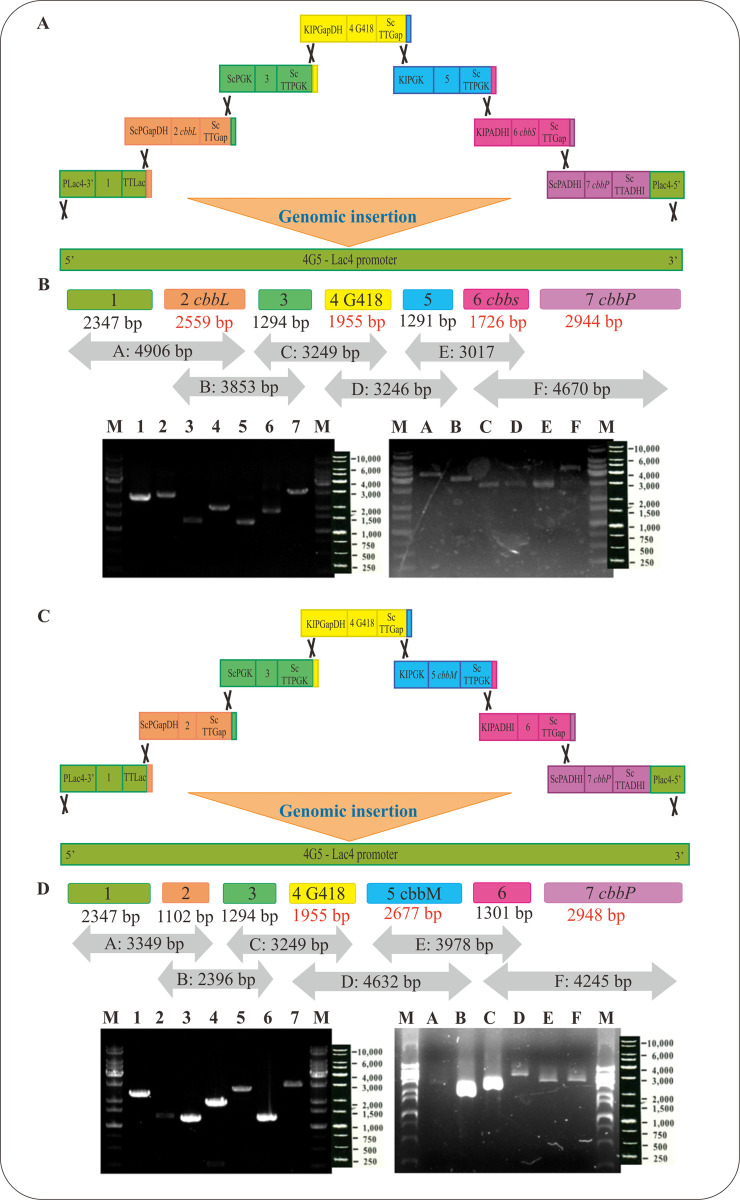
The constructions of form I and form II RuBisCO, PCR products of individual gene cassette and the combined gene cassettes.(A) The designated gene cassettes of form I RuBisCO genes. Each of the four gene cassettes contains its independent promoter, a gene fragment coding region, a terminator, and a 46 bp fragment at the 3’ end of the gene cassette that is homologous to its neighboring gene cassette. After the electroporation, the gene cassettes are assembled in the predesignated order. (B) PCR products of RuBisCO gene cassettes in form I RuBisCO (left panel) were shown as follows: M, DNA ladder; 1, Cassette 1 (2347 bp); 2, Cassette 2-cbbL (2559 bp); 3, Cassette 3 (1294 bp); 4, Cassette 4-G418 (1955 bp); 5, Cassette 5 (1291 bp); 6, Cassette 6-cbbS (1726 bp); 7, Cassette 7-cbbP (2944 bp). PCR products of the combined gene cassettes (right panel) were shown as follows: M, DNA ladder; A, (cassette 1 + cassette 2 cbbL) (4906 bp); B, (cassette 2 cbbL + cassette 3) (3853 bp); C, (cassette 3 + cassette 4 G418) (3249 bp); D, (cassette 4 G418 + cassette 5) (3246 bp); E, (cassette 5 cbbM + cassette 6 cbbS) (3017 bp); F, (cassette 6 cbbS + cassette 7 cbbP) (4670 bp); M, DNA ladder. (C) The designated gene cassettes of form II RuBisCO genes. Each of the three gene cassettes possesses an independent promoter, a gene fragment, a terminator, and a 46 bp fragment homologous to its neighboring cassette. After the electroporation, the gene cassettes are assembled in the predesignated order. (D) PCR products of RuBisCO gene cassettes in form II RuBisCO (left panel) were shown as follows: M, DNA ladder; 1, Cassette 1 (2347 bp); 2, Cassette 2 (1102 bp); 3, Cassette 3 (1294 bp); 4, Cassette 4-G418 (1955 bp); 5, Cassette 5-cbbM (2677 bp); 6, Cassette 6 (1301 bp); 7, Cassette 7-cbbP (2948 bp). PCR products of the combined gene cassettes (right panel) were shown as follows: M, DNA ladder; A, (cassette 1 + cassette 2) (3349 bp); B, (cassette 2 + cassette 3) (2396 bp); C, (cassette 3 + cassette 4 G418) (3249 bp); D, (cassette 4 G418 + cassette 5 cbbM) (4632 bp); E, (cassette 5 cbbM + cassette 6) (3978 bp); F, (cassette 6 + cassette 7 cbbP) (4245 bp); M, DNA ladder.